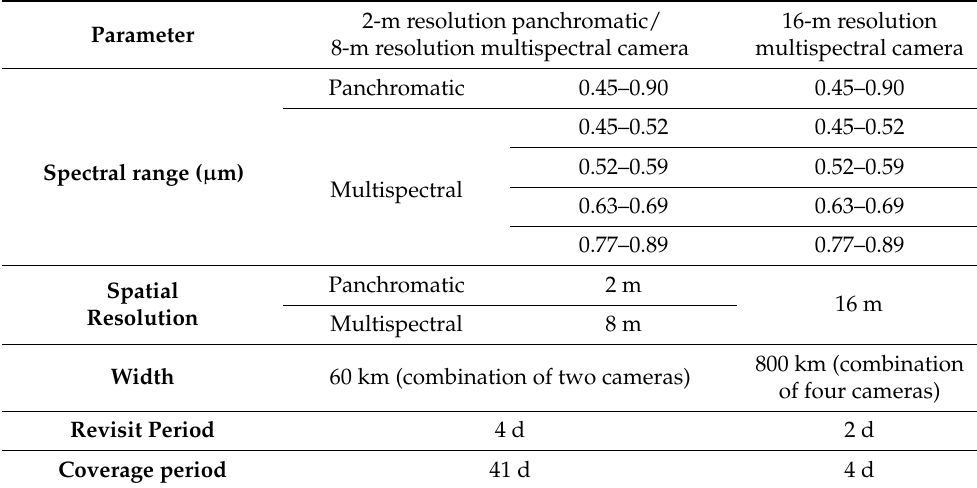
Table 1. Technical specifications of the GF-1